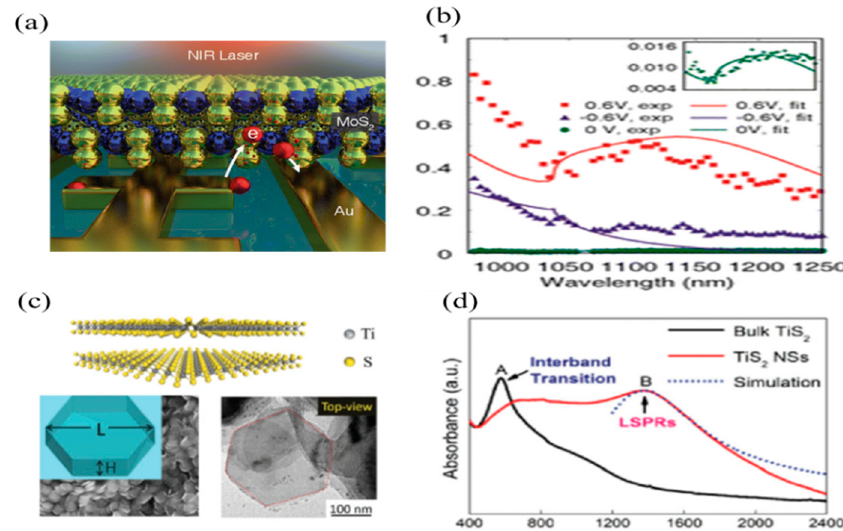
Figure 10. ( a ) The schematic of Hot Electron-Based Near-Infrared Photodetection Using Bilayer MoS 2 ; ( b ) the photo-responsivity of the photodetector in the NIR-band under different biased voltages (Reproduced with the permission of Reference [147]. Copyright 2015, American Chemical Society); ( c ) the schematic illustration and morphologies of TiS 2 -based nanoplatelets; ( d ) the SPR enhanced spectral response in the NIR-band (Reproduced with the permission of Reference [149]. Copyright 2016, Wiley-VCH).